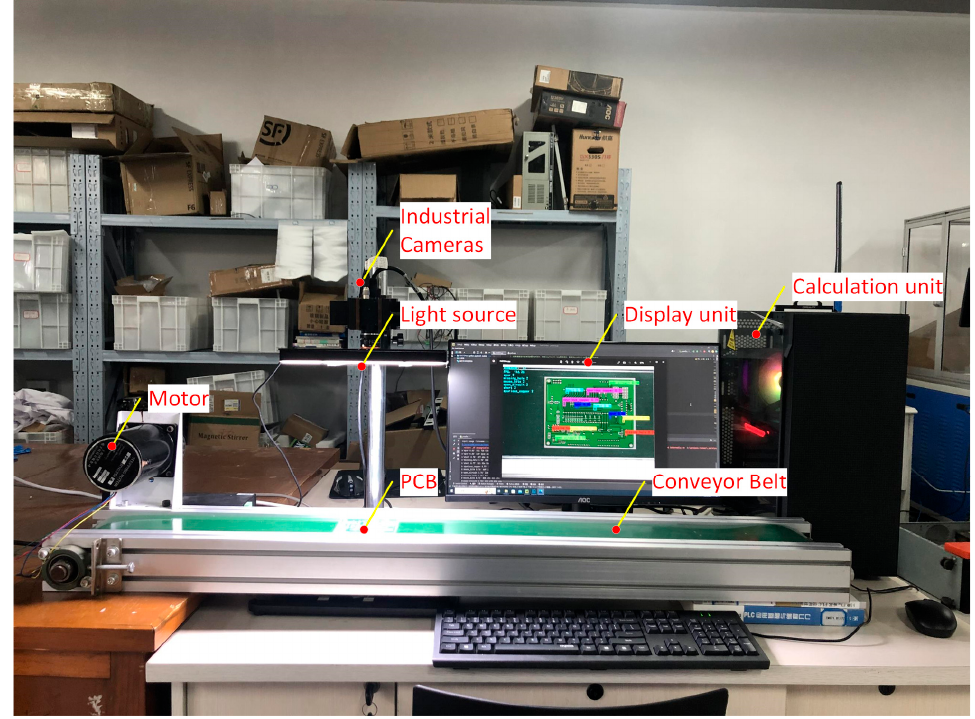
Figure 4. PCB surface defects real-time detection experimental platform.